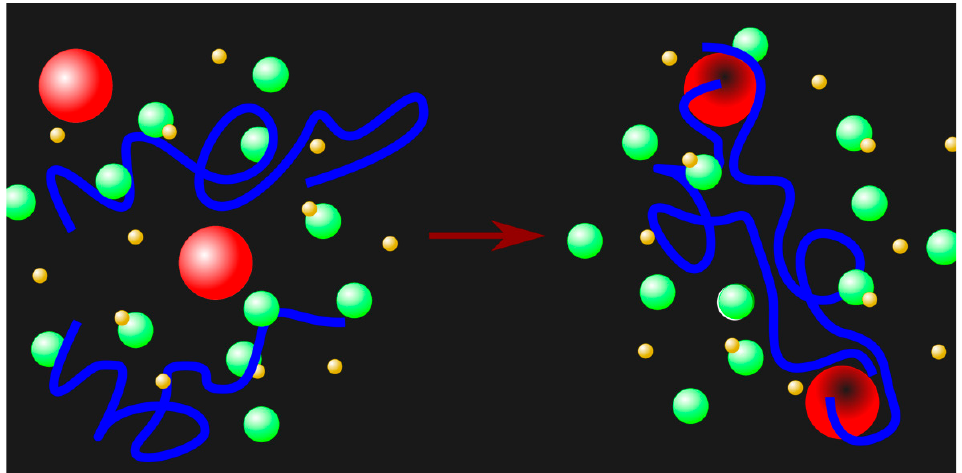
Figure 7. The possible idealized scheme of solid impurities (red spheres) being blocked by PAA-F1 molecules (blue ribbon); green spheres correspond to sulfate ions, yellow spheres—to calcium cations.